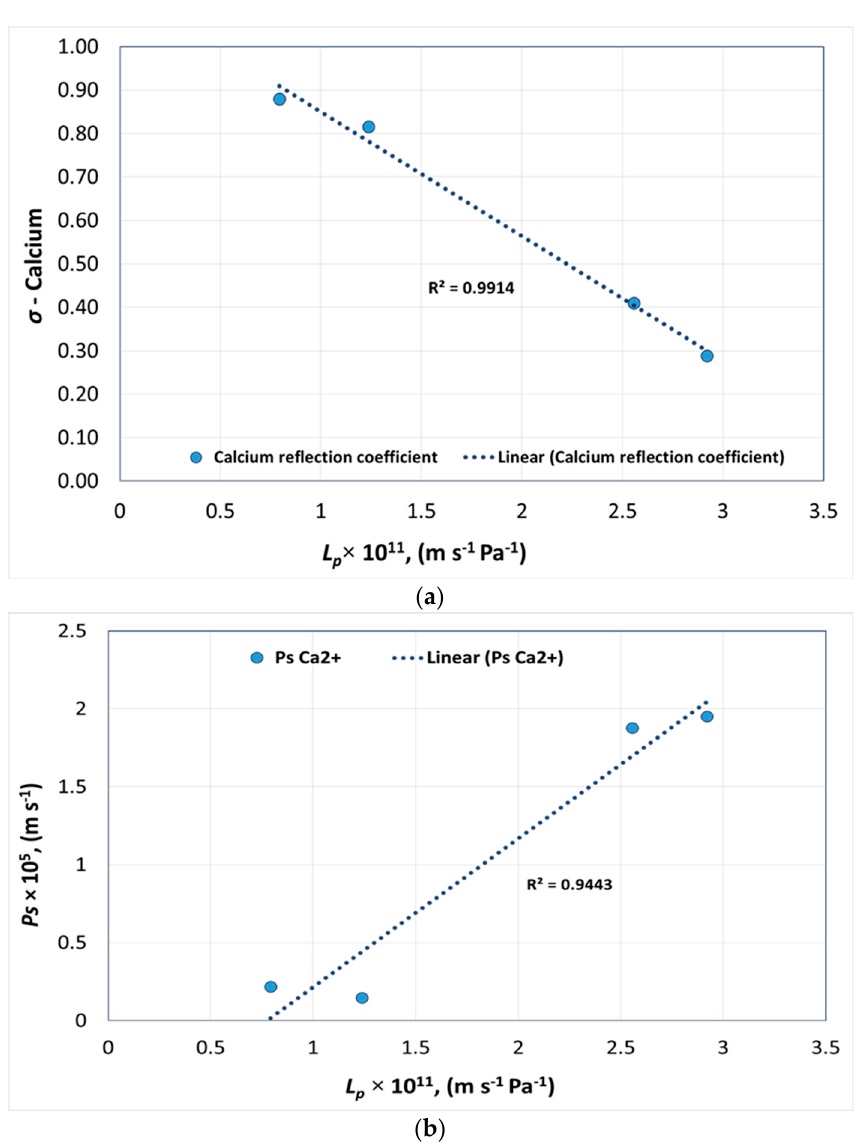
Figure 6. Pure water permeability versus ( a ) reflection coefficient and ( b ) solute permeability of calcium.